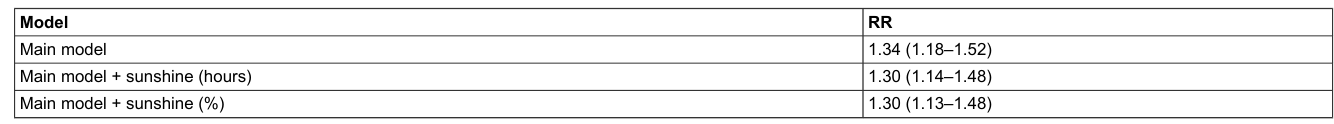
Table S3: Confounding by sunshine